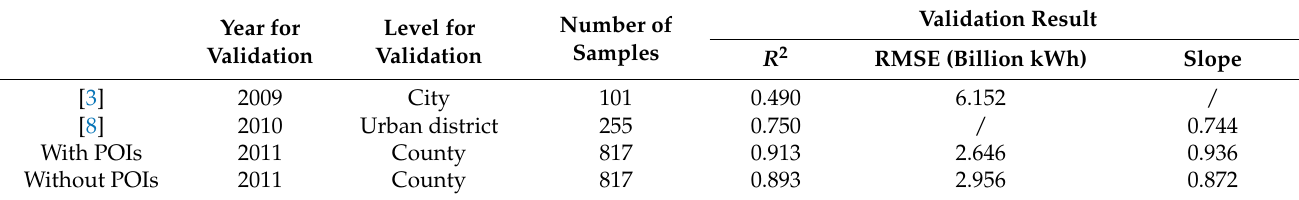
Table 2. Statistics for the comparison of the performance of different EPC prediction methods.